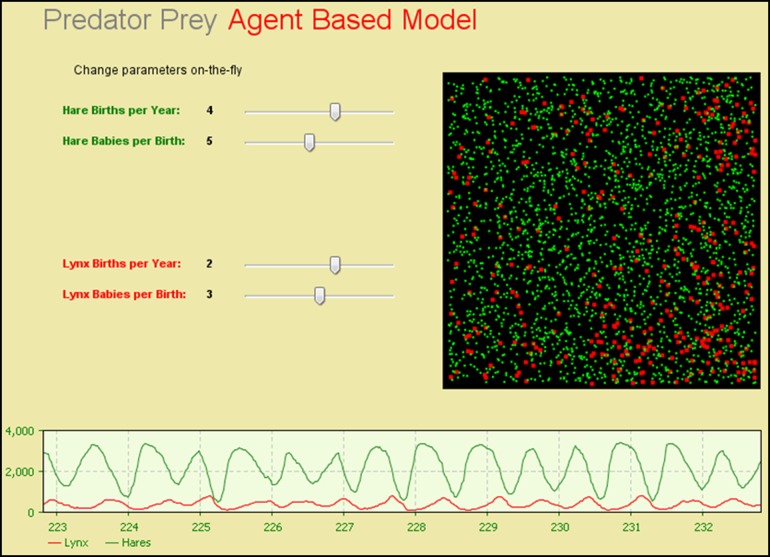
The predator-prey agent-based model (AnyLogicTM).